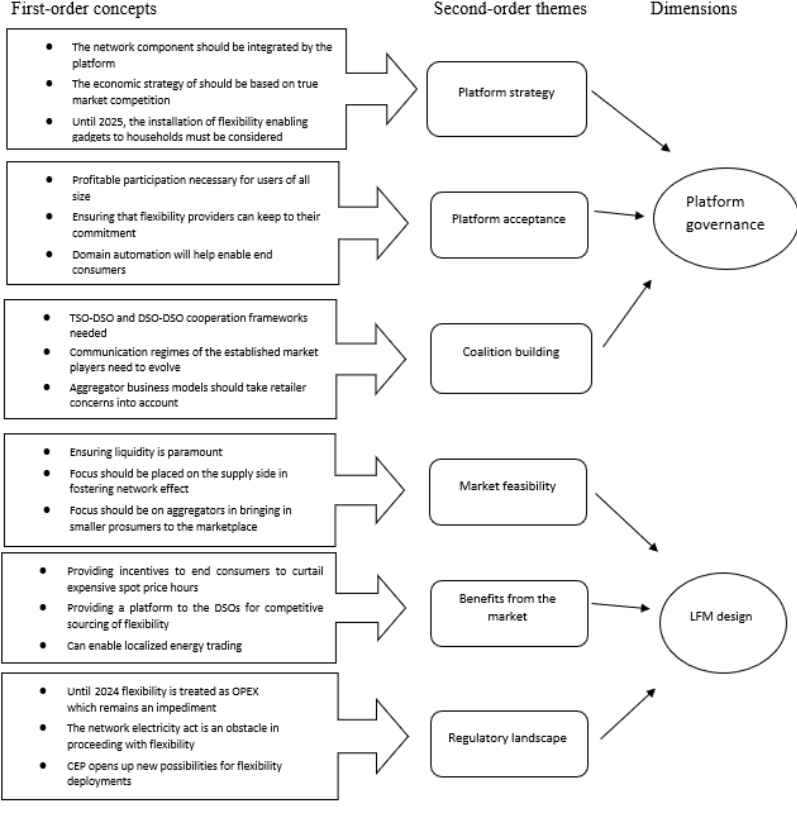
Figure 4. Data Figure 4. Data structure.